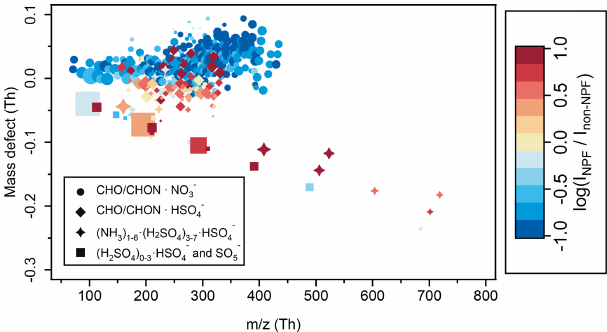
Figure 12. Mass defect plot of differences in negative cluster ion composition between NPF and non-NPF days. The negative ion composition of NPF events was averaged over all NPF days from 08:00 to 12:00 in January, April, and May 2018 (when APi-TOF was operating in negative-ion mode; see Sect. 2.2.1) at CHC. The ion composition of non-NPF days was averaged over non-NPF days from 08:00 to 12:00 for the same period. The x axis is the ex- act mass of cluster ions, and the y axis is the mass defect. The color code indicates ratios (in log scale) between median signals of each ion determined in NPF events ( I NPF ) and non-NPF periods ( I non-NPF ). The marker size is proportional to the log-transformed median signals of ions observed in the NPF events that occurred in Figure 11. Connection between the maximum number of H 2 SO 4 January, April, and May. Note that (HNO 3 ) 0–2 (cid:113) (in addition to HSO − ) observed in the (H 2 SO 4 ) 2 HSO − and were not included 4 4 (cid:113) (cid:113) (NH 3 ) 1–6 (H 2 SO 4 ) 3–7 HSO − cluster ions during NPF events and 4 (a) the number of NPF days; (b) proportions of different NPF classes.